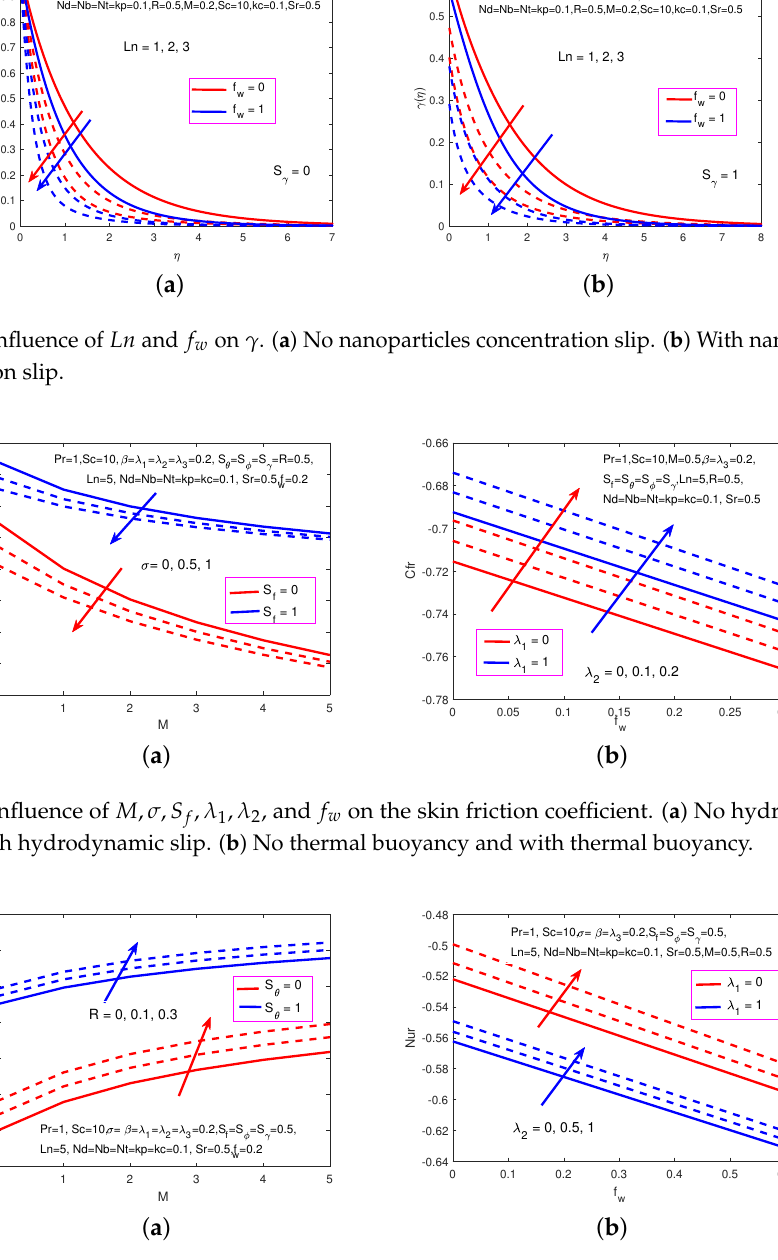
Figure 15. Influence of M , R , S θ , λ 1 , λ 2 , and f w on the reduced Nusselt number. ( a ) No thermal slip and with thermal slip. ( b ) No thermal buoyancy and with thermal